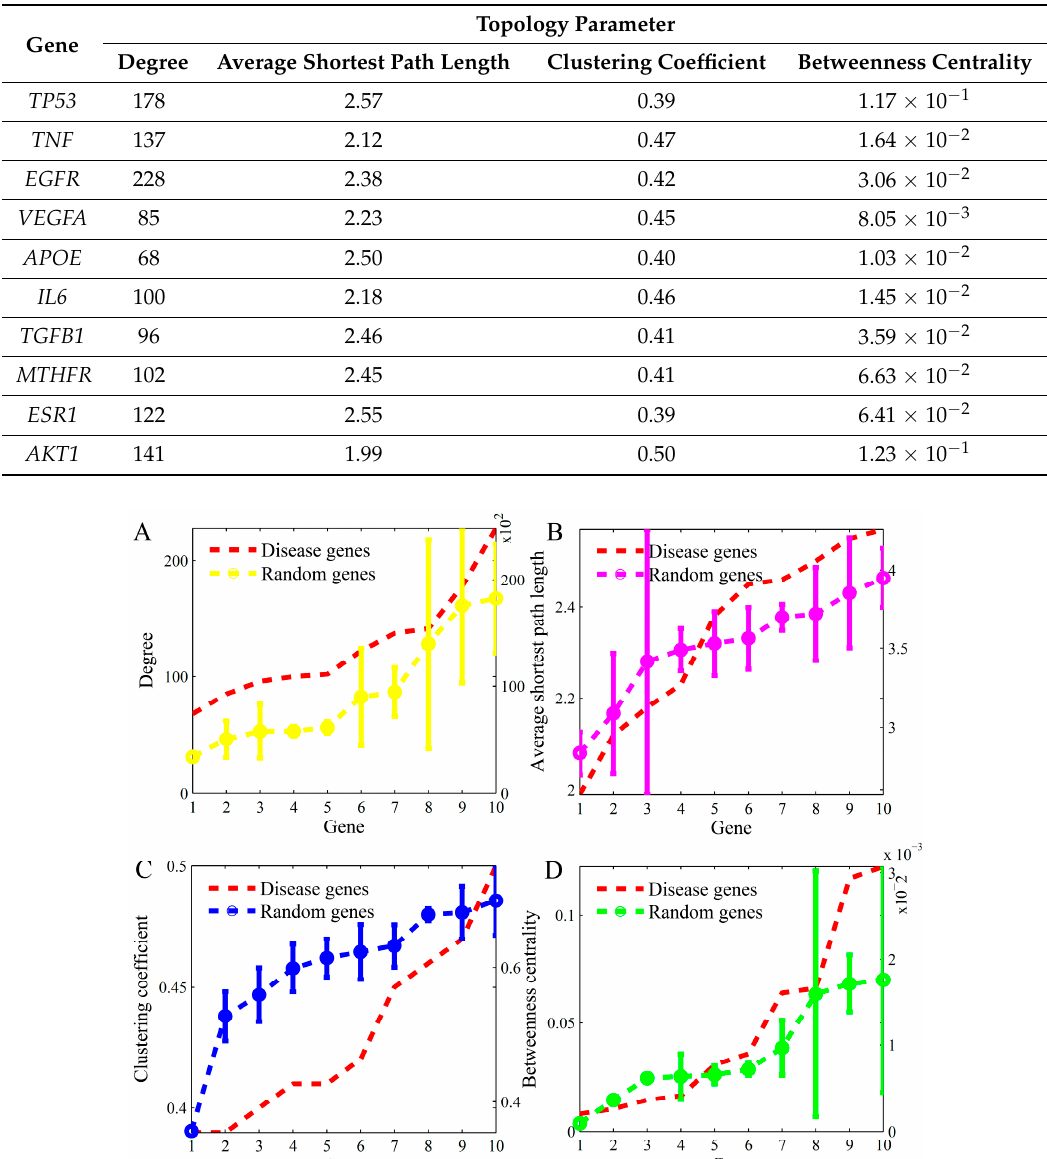
Table 2. The values of network topology parameters in the top-ten popular genes.